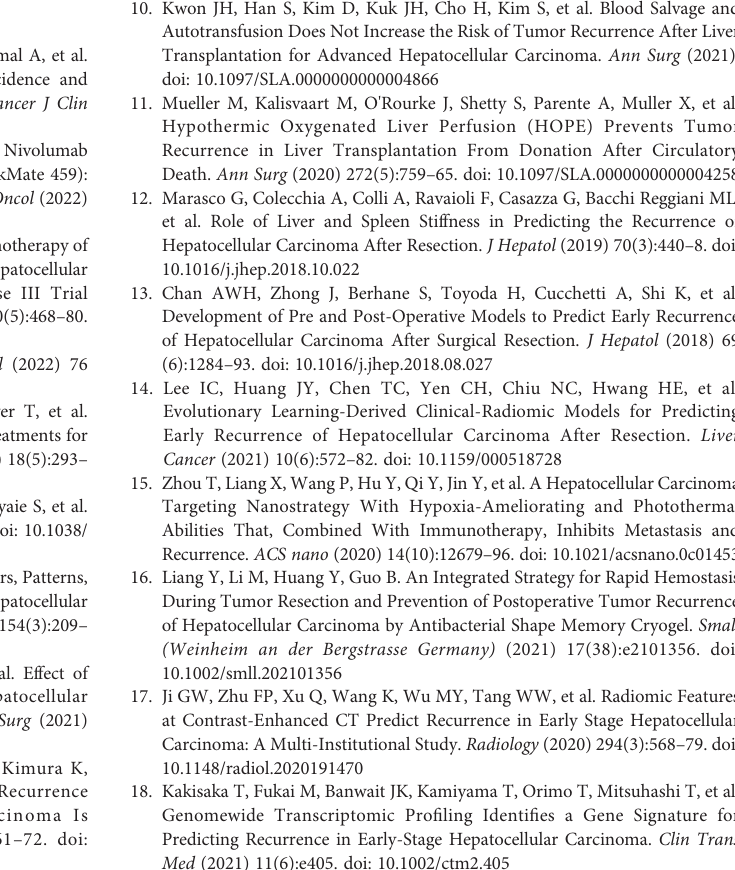
Supplementary Figure 1 | Time-dependent ROC curves in different cohorts. (A) ROC curves of the TCRS in the training cohort. (B) ROC curves of the TCRS in the validation cohort 1. (C) ROC curves of the TCRS in the validation cohort 2 (GSE14520). (D) ROC curves of the GRS in the training cohort. Supplementary Figure 2 | Comparison of DFS time between patients with disease-free and recurrent HCC. (A) Comparison results in the training cohort. (B) Comparison results in the validation cohort 1. (C) Comparison results in the validation cohort 2 (GSE14520). Supplementary Figure 3 | External validation of the TCRS ef fi ciency in validation cohort 2 (GSE14520). (A) Survival status and abundances of effector memory CD8 T cells, regulatory T cells and follicular helper T cells between the high- and low- score groups. (B) Kaplan-Meier curve for the two groups in the validation cohort 2. (C – F) The expression levels of the immune score (C) , ESTIMATE score (D) , stromal score (E) andtumorpurity (F) between thetwogroups. (G,H) Theexpressionlevels of 28 immune cells of the two groups visualized by heatmap (G) or boxplot (H) . *p < 0.05, **p < 0.01, ***p < 0.001, ****p < 0.0001, ns: not signi fi cant. Supplementary Figure 4 | Quality control of the HCC scRNA data. (A) Expression pro fi les of T cells from primary and relapsed HCC samples. (B) Correlations between nFeature-RNA and nCount-RNA (left panel) or nFeature-RNA and percent.mt (right panel) in T cells. (C) UMAP plot separated by tissue types. (D) UMAP plot separated by cell cycle. (E) UMAP plot showing the expression levels of mitochondrial genes. Supplementary Figure 5 | The expression levels of the fi fteen prognostic genes constructed for the TCRS between the high- and low-score groups in the training cohort. *p < 0.05, **p < 0.01, ***p < 0.001, ns: not signi fi